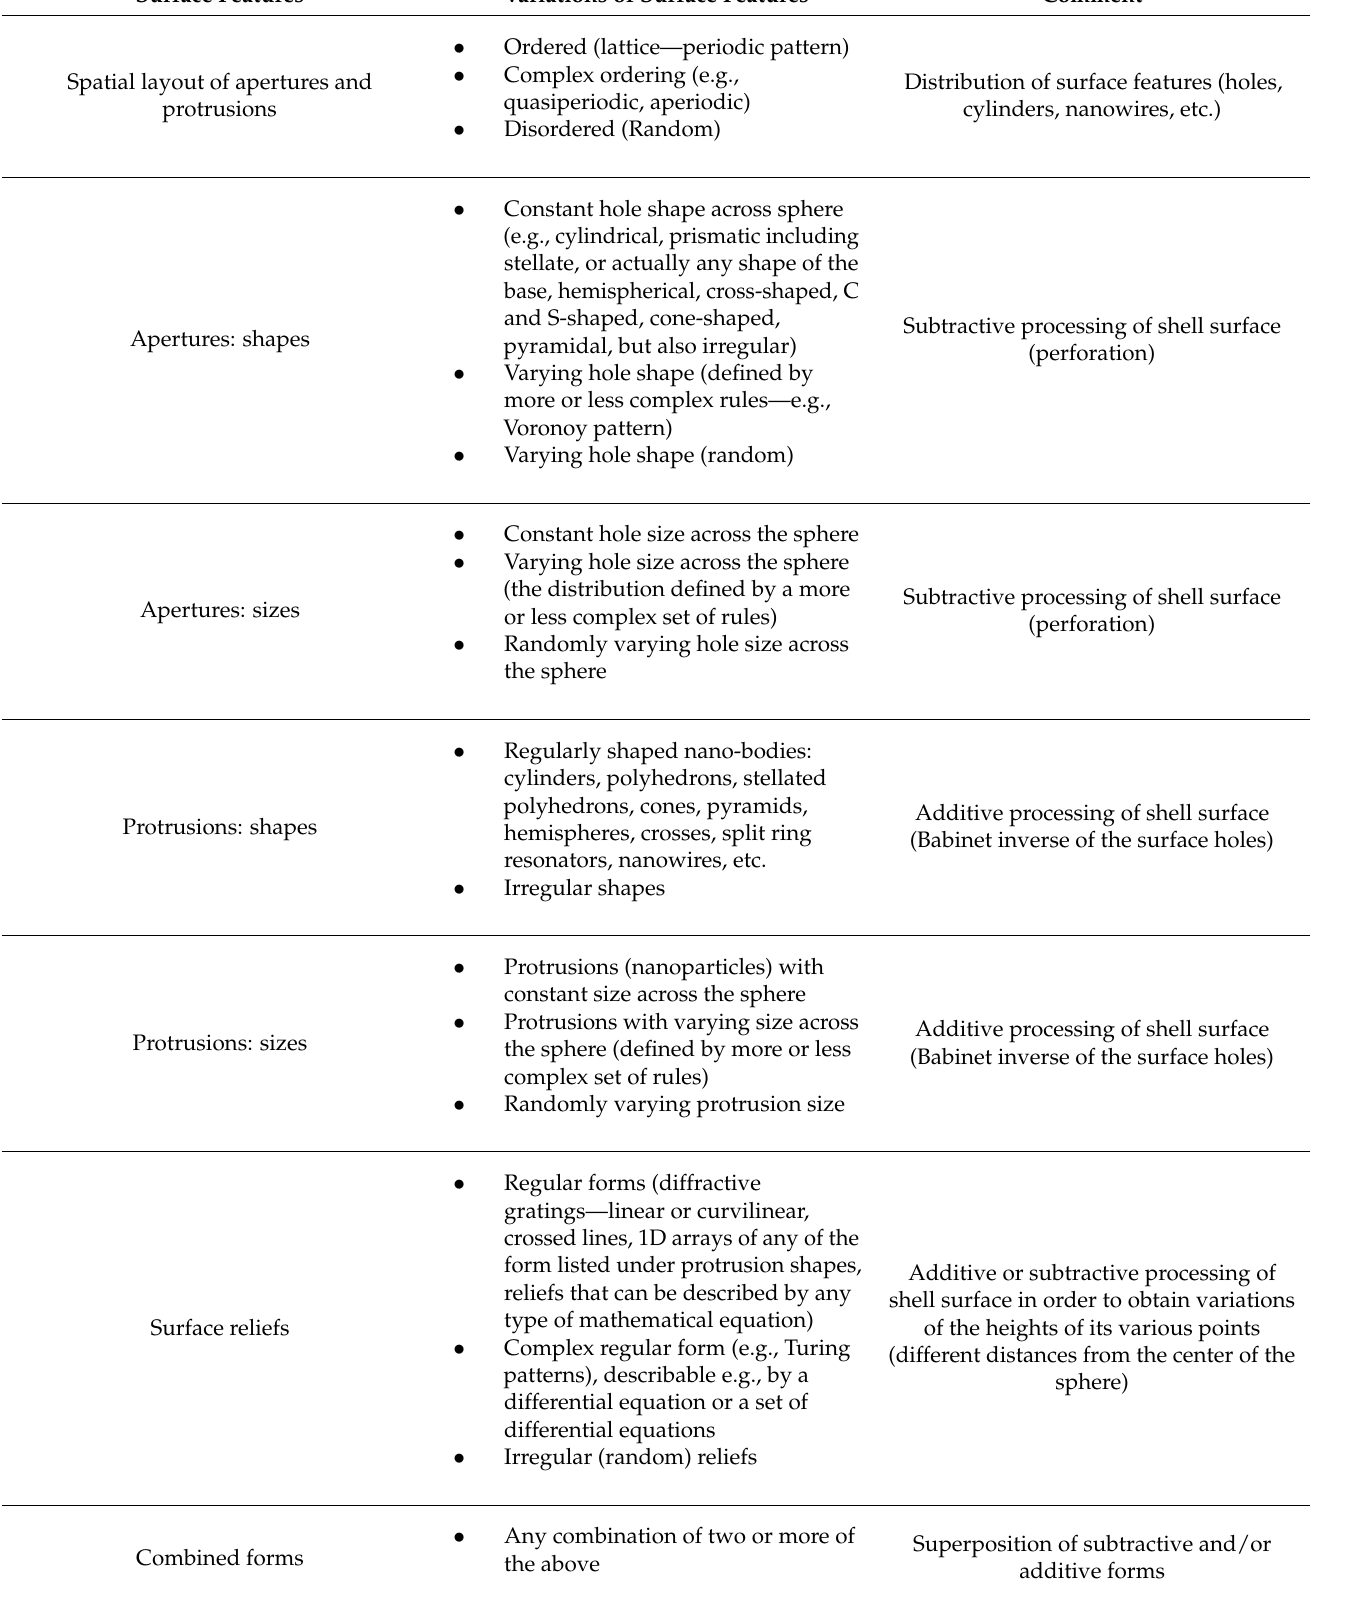
Table 1. A proposal of a classification of the potential generalizations of brochosome-inspired plasmonic particles. Surface